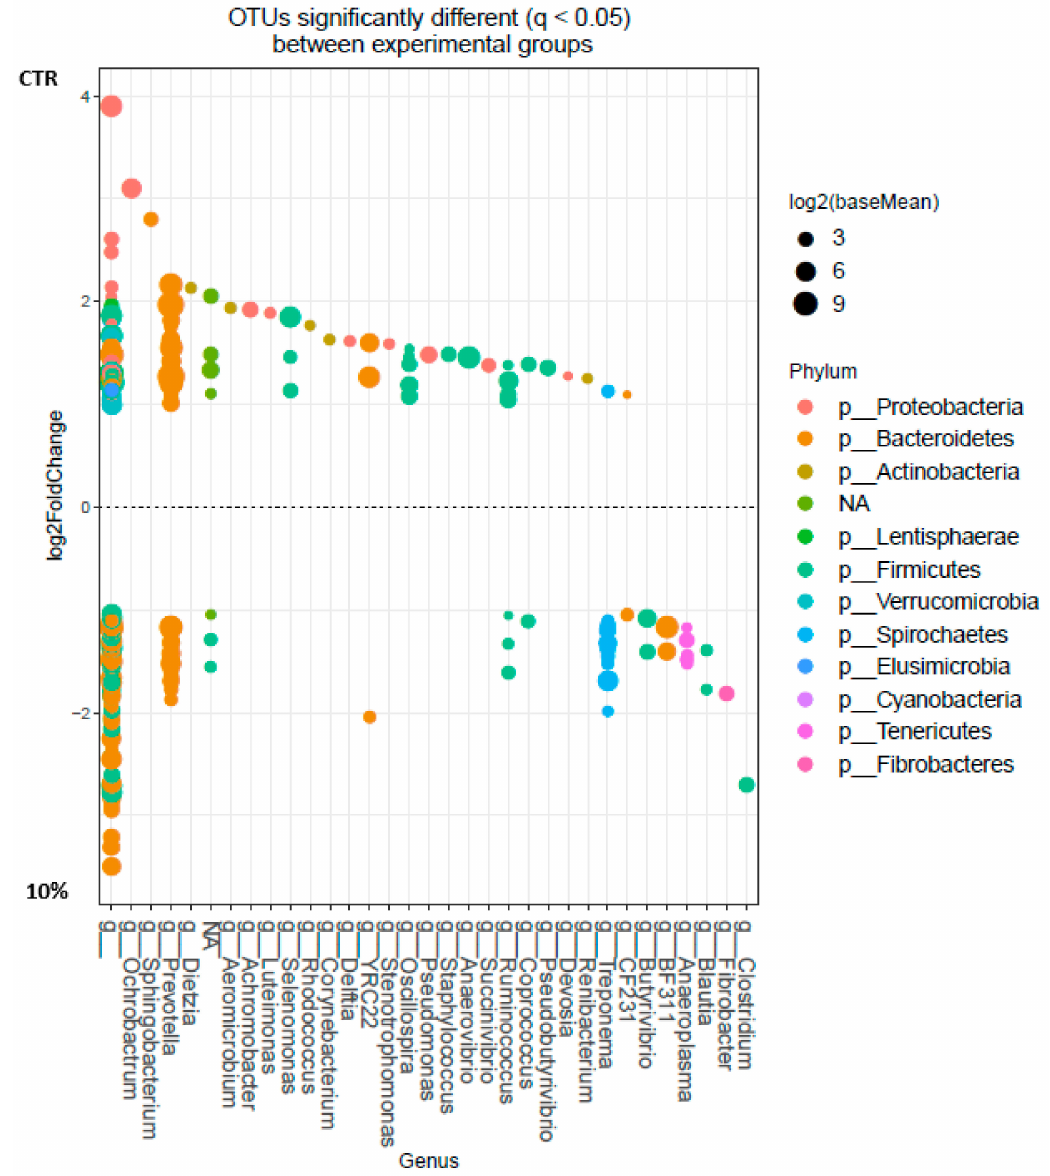
Figure 4. Operational Taxonomic Unit (OTU) at genus level significantly di ff erent (q < 0.05) between rumen samples of sheep fed control (above; n = 8) and concentrate with 100 g / kg of SCG (10%, below; n = 9). Each point represents a single OTU coloured by phylum and grouped on the x-axis by taxonomy, size of point reflects the log2 mean abundance of the sequence